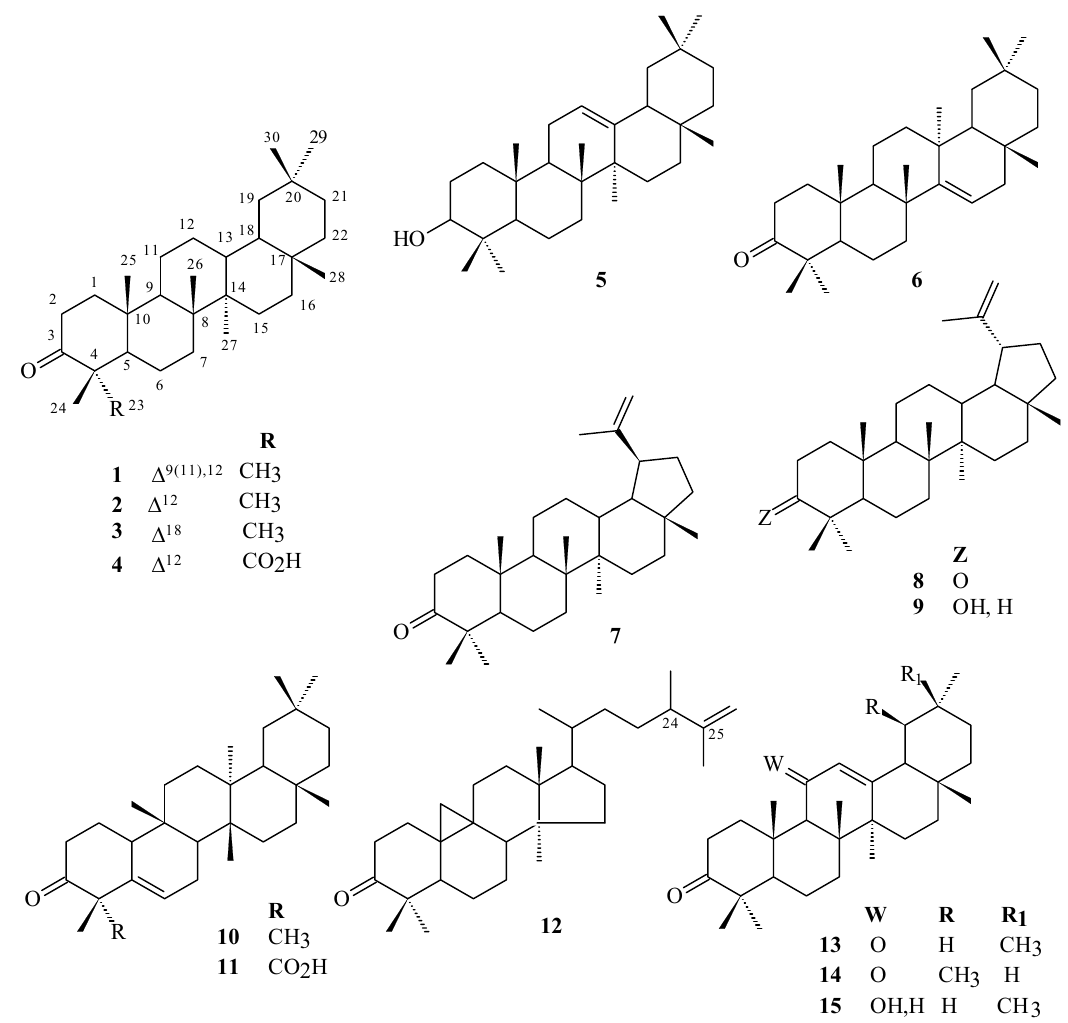
Fig. 3 – Structures of the Triterpenoids characterized in the V. graminifolia